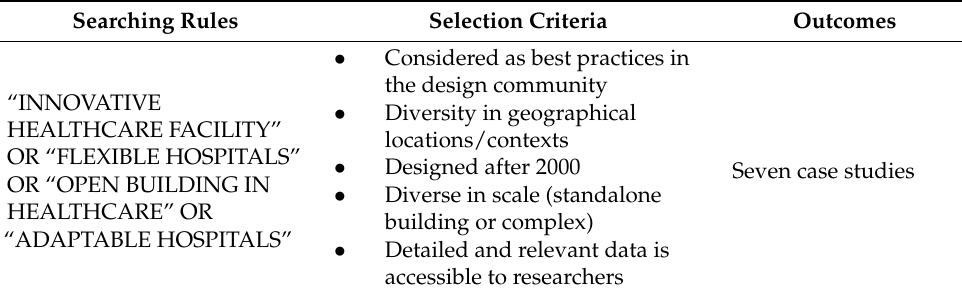
Table 3. Searching rules and selection criteria for case